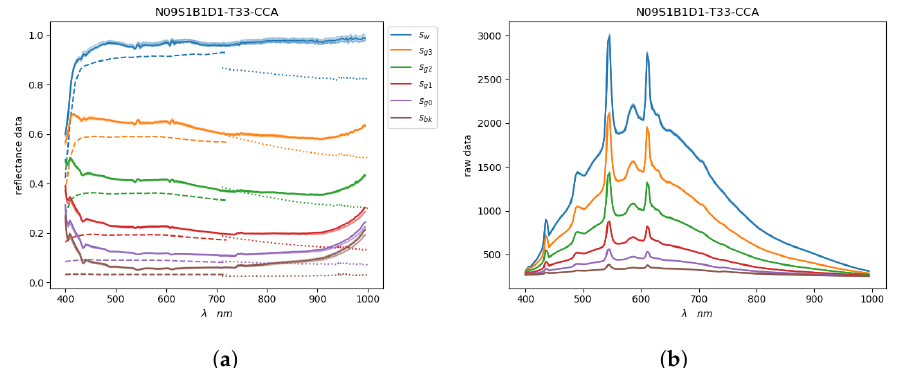
Figure 7. Spectra extracted from the CCA grayscale on the image N09S1B1D1T33. In ( a , b ) the solid lines represent the mean reflectance and raw acquired values respectively. In ( a ) the dashed lines represent the reference RS ( 1 ) in 400nm to 700nm and the dotted lines represent the reference RS ( 2 ) in 700nm to